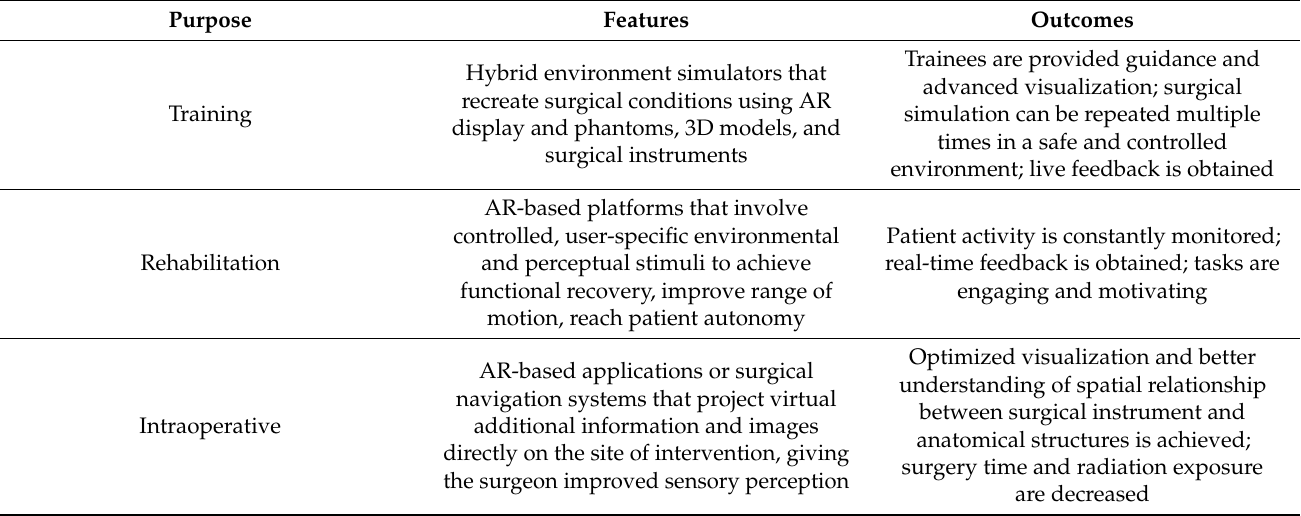
Table 2. Overview of the main features and expected outcomes of AR-based